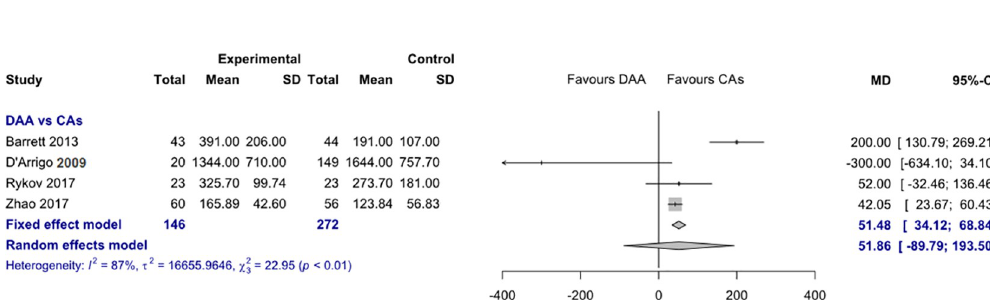
Fig 3. Comparison of the incision length in cm. DAA, direct anterior approach; CAs, conventional approaches; SD, standard deviation; MD, mean difference; CI, confidence interval.